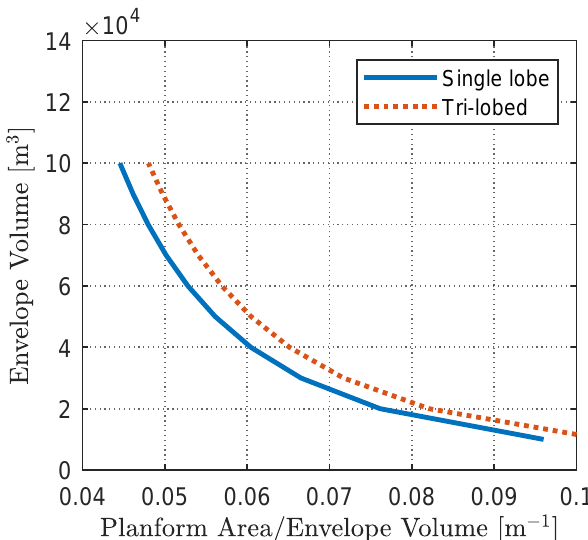
Figure 2. Surface-to-volume ratio versus envelope